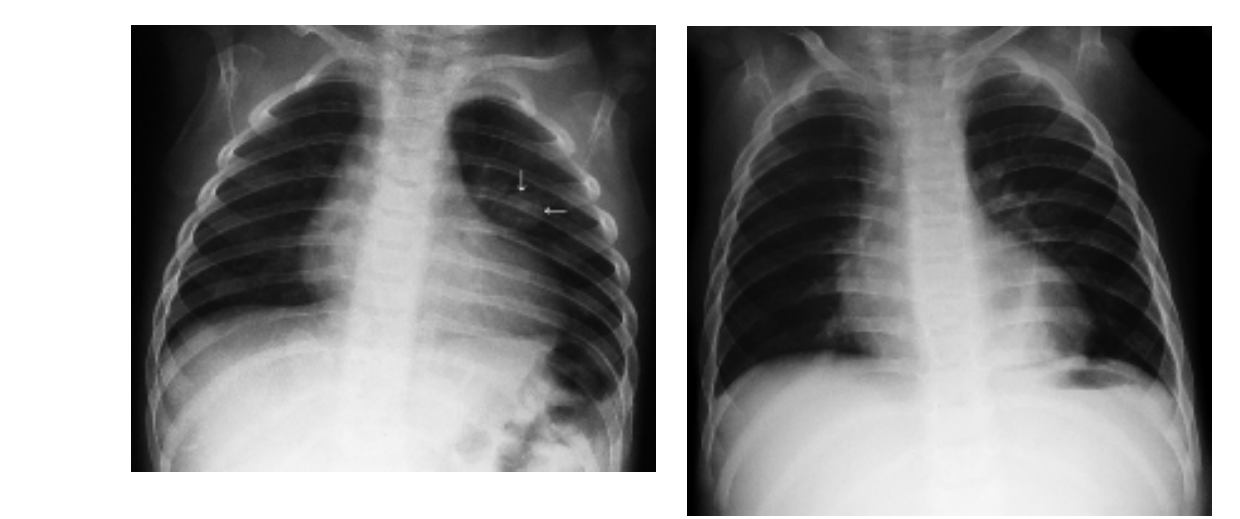
Bronchogenic cyst. Chest radiograph of an 8-month-old girl with an intrapulmonary bronchogenic cyst in the left lung. The rounded lesion was found incidentally, and the girl was asymptomatic.